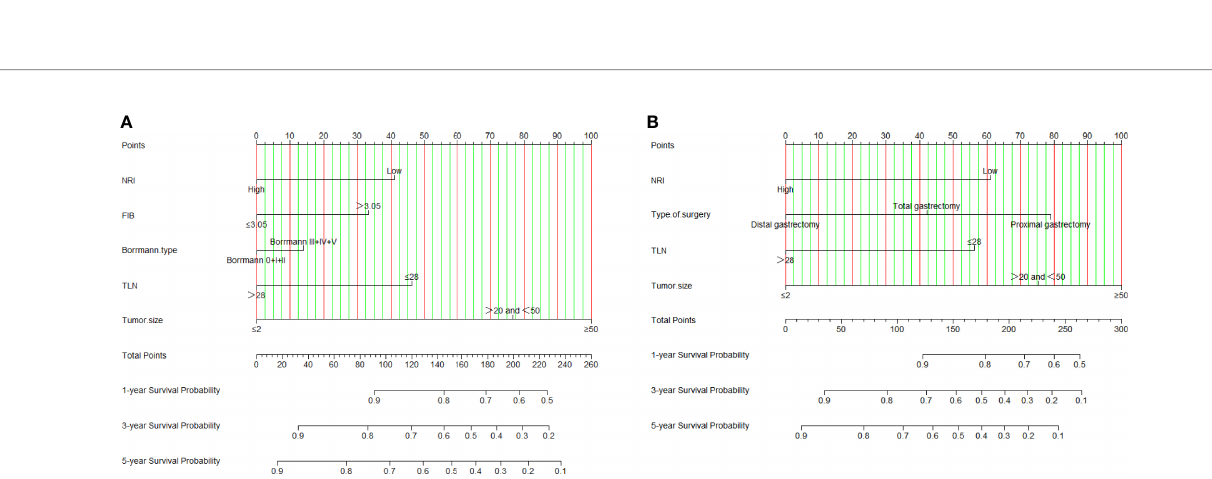
FIGURE 3 | NRI-based nomogram for evaluating disease-free survival (DFS) and overall survival (OS). (A) NRI-based nomogram for evaluating DFS; (B) NRI-based nomogram for evaluating